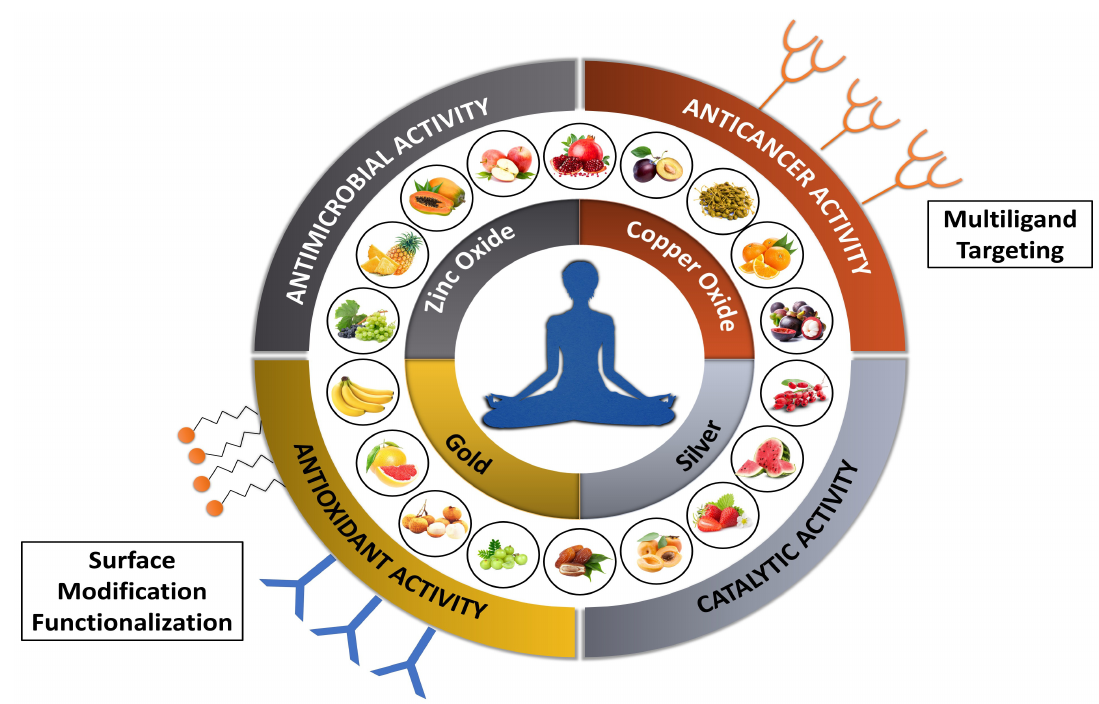
Figure 1. Graphical representation of fruit sources used for synthesizing nanoparticles with potential biological activities.